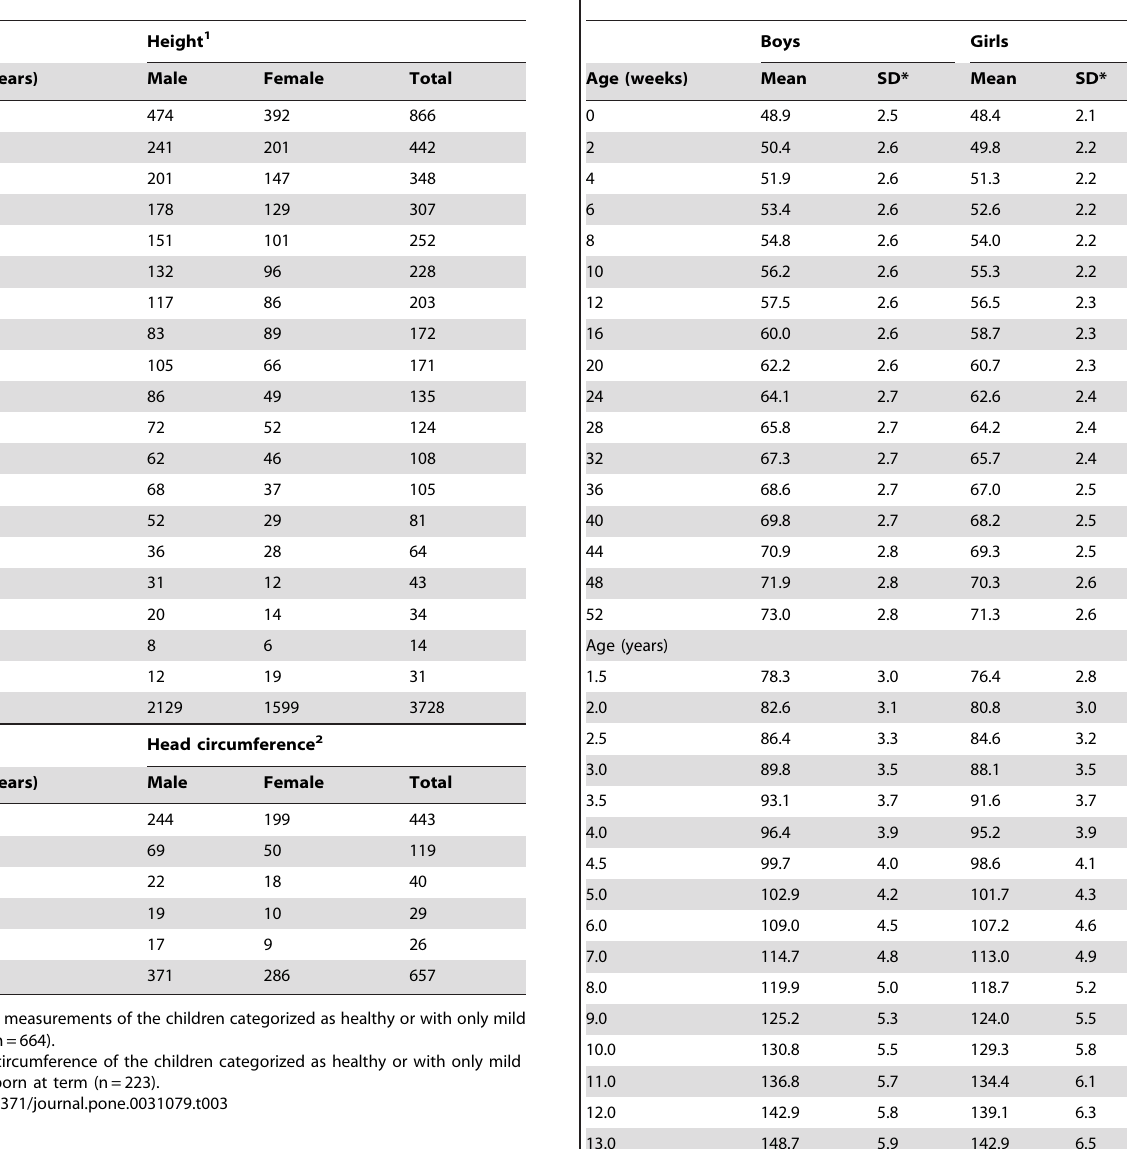
Table 4. Mean height (cm) and standard deviation (SD) of the new references for length/height of Dutch children with Down syndrome, arranged by age and sex.